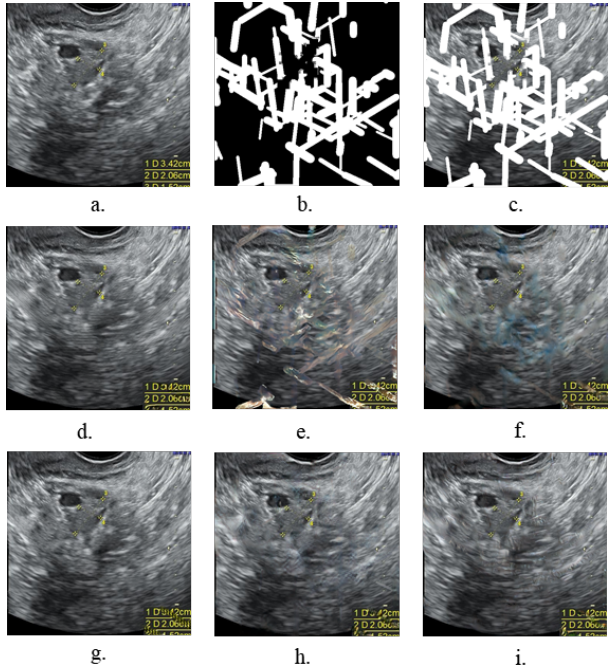
Figure A4. Comparison between the results of our proposed model and those of other models. ( a ) The ground truth image. ( b ) The mask for the ground truth image. ( c ) The masked image. ( d ) LaMa method. ( e ) GL method. ( f ) DF 1 method. ( g ) Our method. ( h ) PC method. ( i ) DF 2